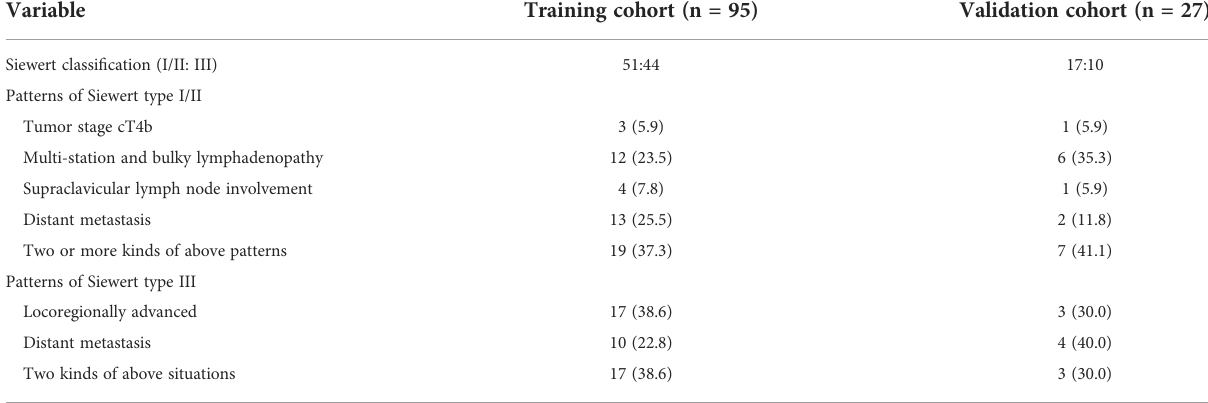
TABLE 2 The detailed patterns of enrolled cases with unresectable adenocarcinoma of esophagogastric junction. Variable